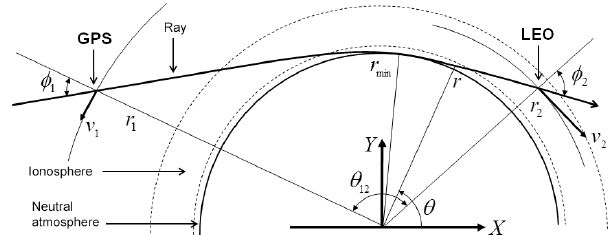
Figure A1. Layout of ray